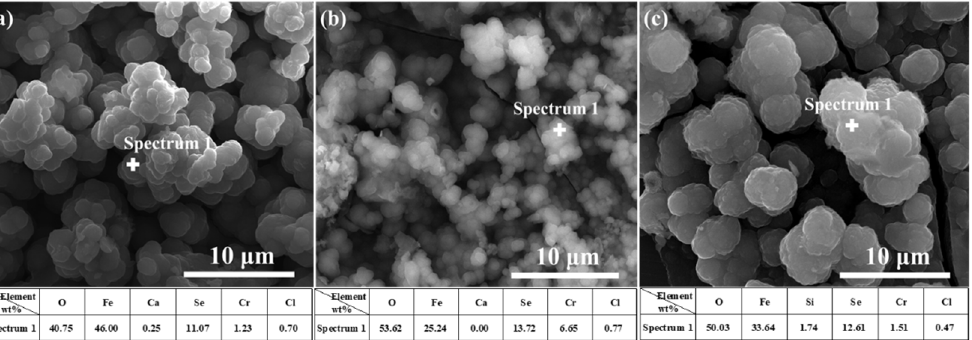
Figure 11. The EDS analysis of 304 stainless ‐ steel samples after being treated by polarization meas ‐ urements in different solutions and a 4 week immersion test in SG + Na 2 SeO 4 solution: ( a ) SG + CaCl 2 solution; ( b ) SG + Na 2 CO 3 solution; ( c ) SG + Na 2 SiO 3 solution.